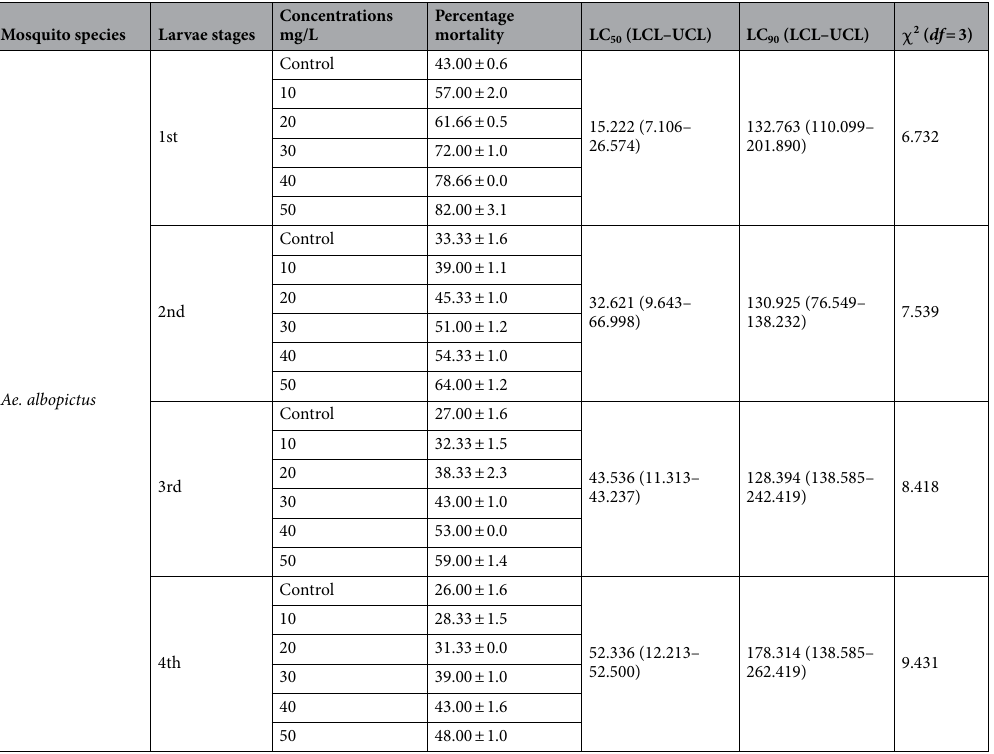
Table 2. Rapid synthesized SeNPs larvicidal activity against Ae. Albopictus